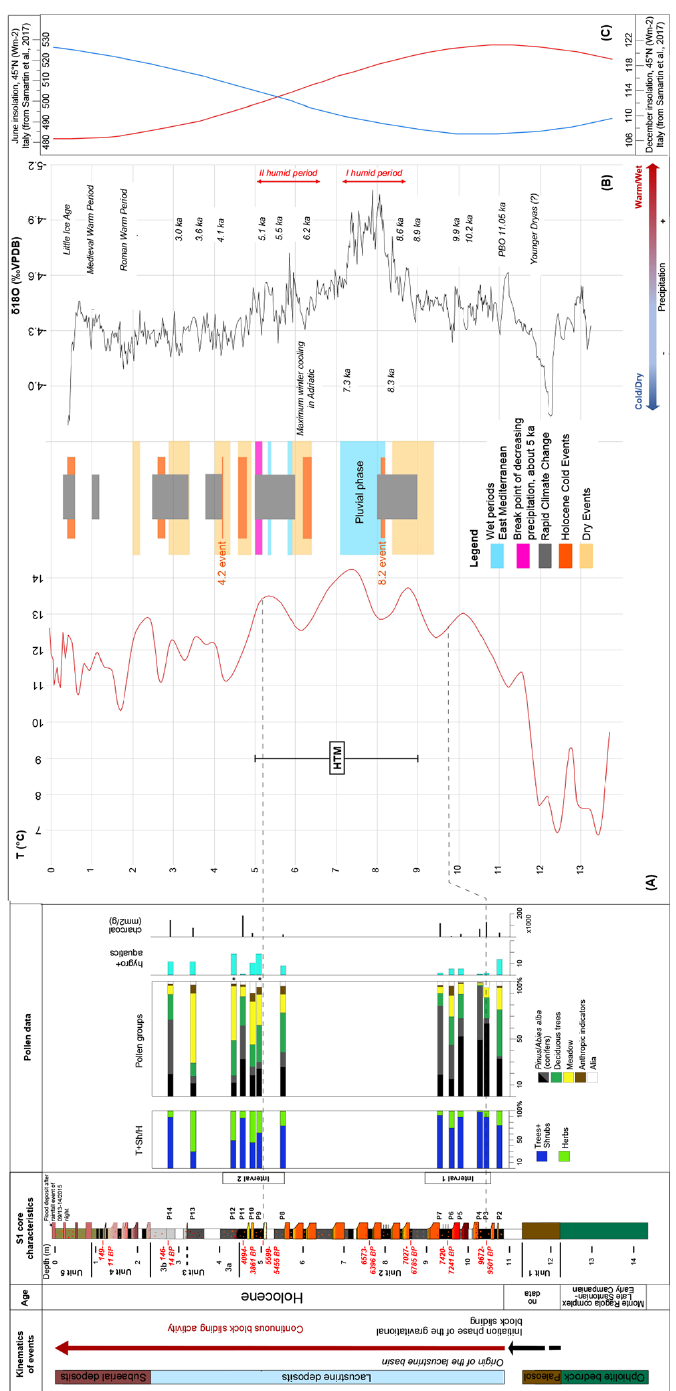
Figure 7. Stratigraphy of core S1, main palynological features and microcharcoal content. Relative abundances of the pollen groups that are explained in the text (Sect. 3.3) are reported along with the frequencies of hygrophilous herbs and aquatics. Asterisks point to samples containing coprophilous fungi and other spores like Sporormiella , Dicrocoelium and Ascaris . These data are compared with the most relevant paleoclimate reconstructions available from the literature for the area of interest. (a) Reconstructed mean July air temperature from Lake Verdarolo (from Samartin et al., 2017); (b) δ 18 O speleothem records and reconstructed precipitation trends (mean anomaly time series) from Corchia cave (slightly modified from Combourieu et al., 2013; Zanchetta et al., 2011; Zhornyak et al., 2011); and (c) June (red) to December (blue) insolation values reported for 45 ◦ N (from Samartin et al., 2017). Main Holocene climate phases and events are also shown (Regattieri et al., 2014). Available radiocarbon ages are reported as calibrated years